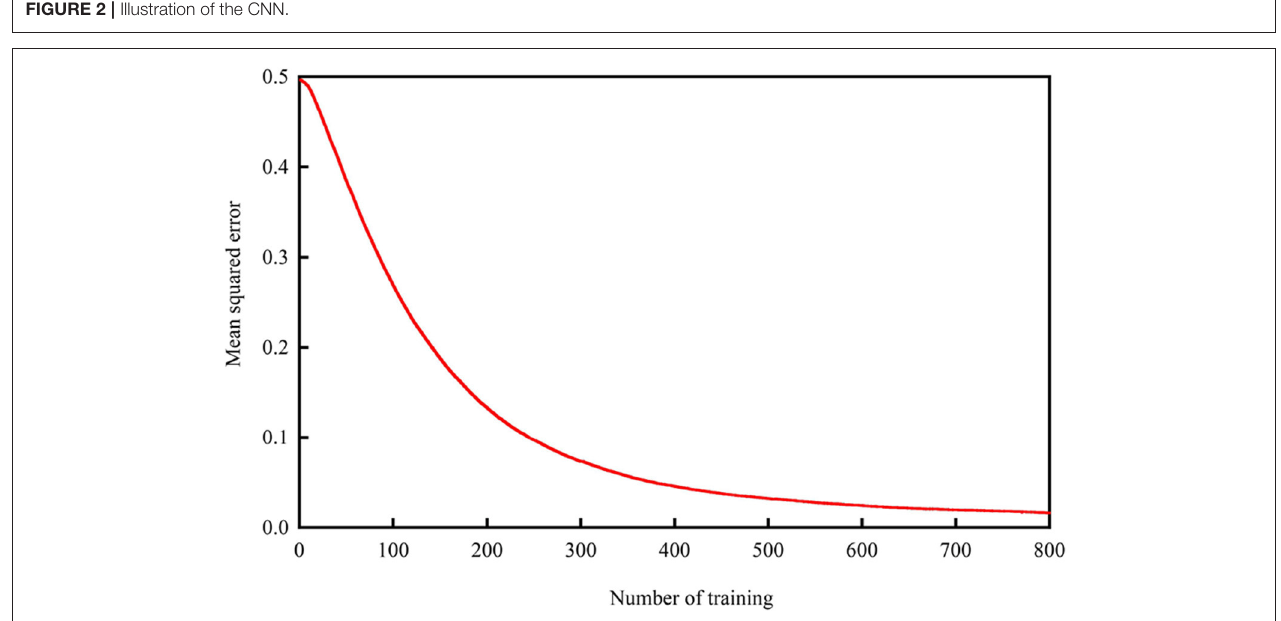
FIGURE 2 | Illustration of the CNN.